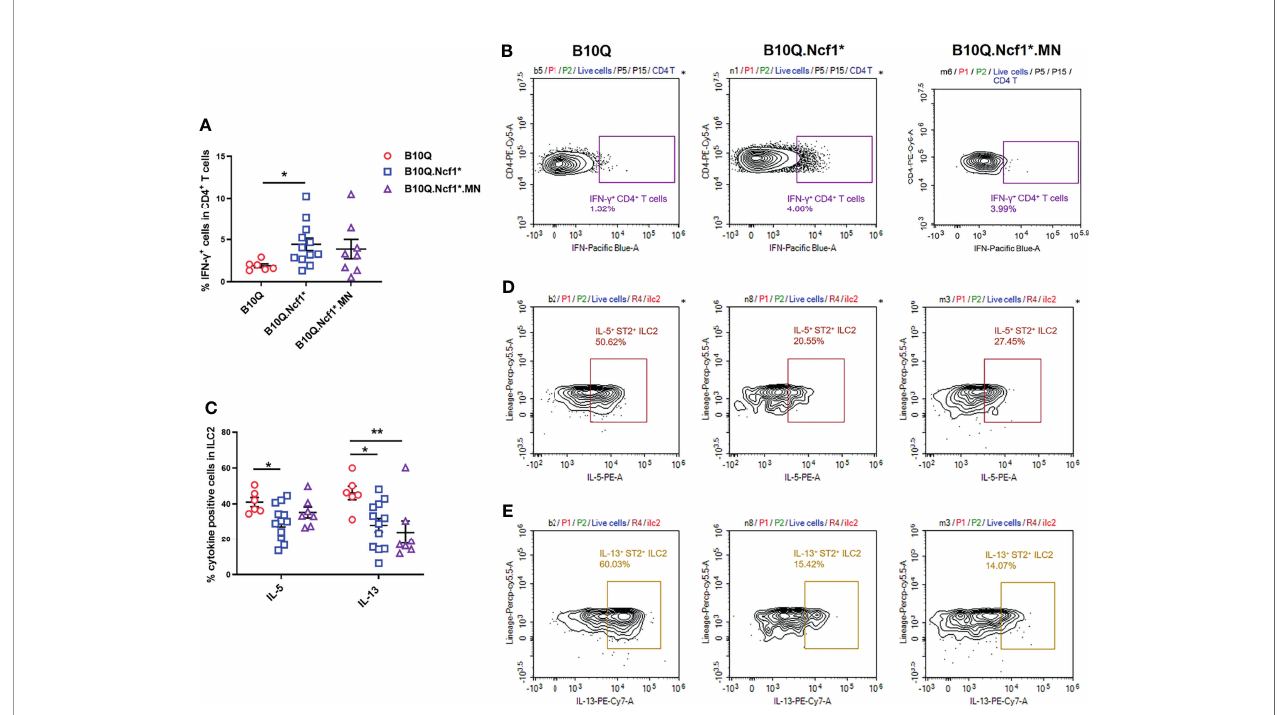
FIGURE 6 | Activation of Th1 cells and ILC2 is regulated by Ncf1 in lung in fl ammation induced by IL-33. The IFN- g positive cells in CD4 + T cells (A, B) , and the IL-5 and IL-13 positive cells in ILC2 (C – E) were detected by fl ow cytometry in the whole lung tissues of mice treated with IL-33 (n = 6-12 per group). The proportion of IFN- g positive cells in CD4 + T cells, and that of IL-5 and IL-13 positive cells in ILC2, were analyzed in histograms, and the representative plots are shown. All values are expressed as means ± SEM. * P < 0.05 and ** P < 0.01, using one ‐ way ANOVA with post ‐ hoc comparison (Fisher ’ s)